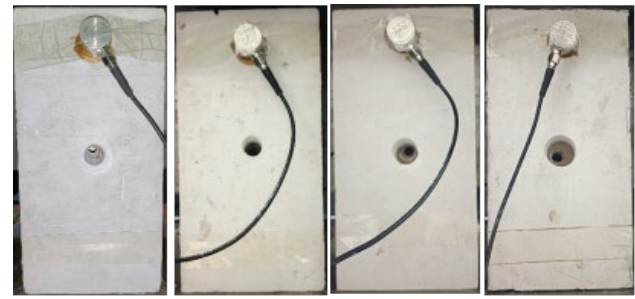
Figure 5. Schematic diagram of some samples.